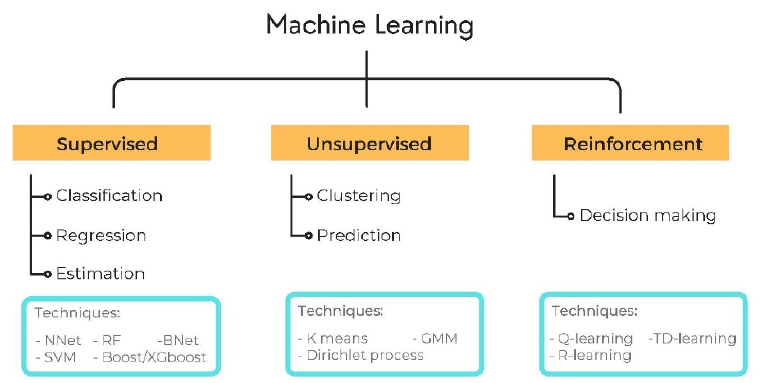
Figure 3. Supervised, unsupervised, and reinforced machine learning.